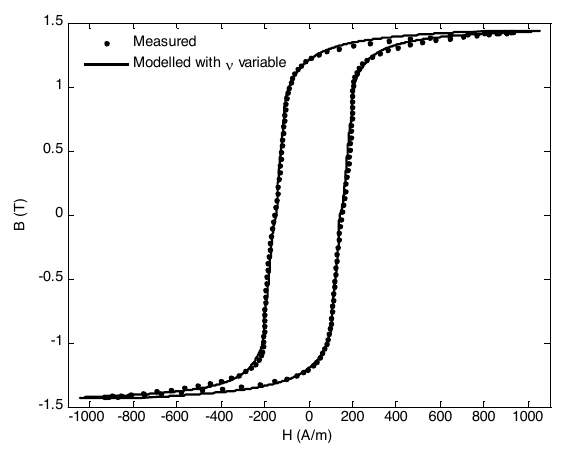
FIGURE 11. Evolution of the errors between modelled and measured power losses at different